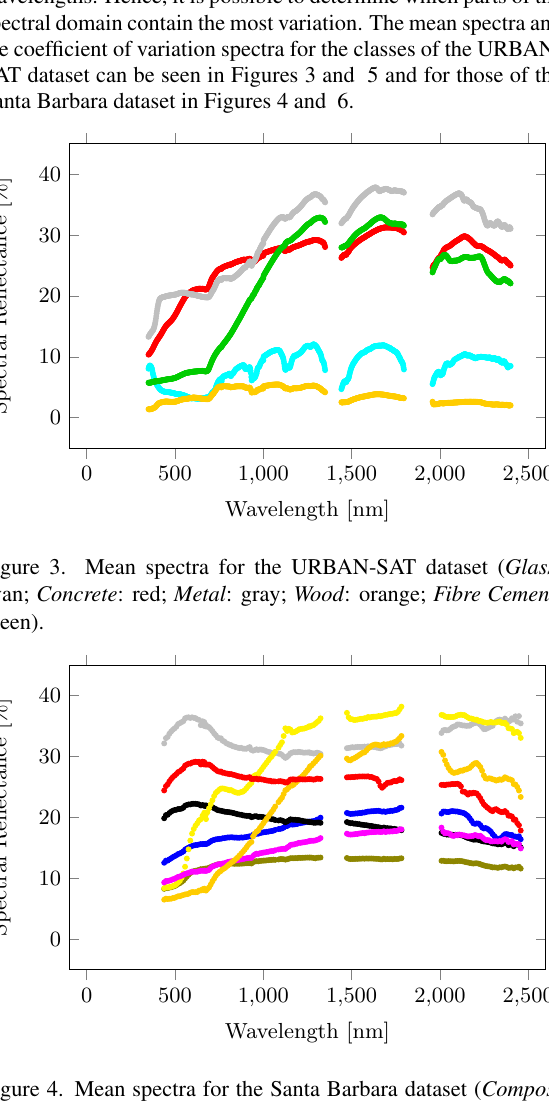
Figure 4. Mean spectra for the Santa Barbara dataset ( Compos- ite : olive green; Gravel : blue; Metal : gray; Asphalt : black; Tile : yellow; Tar : magenta; Wood : orange; Concrete :